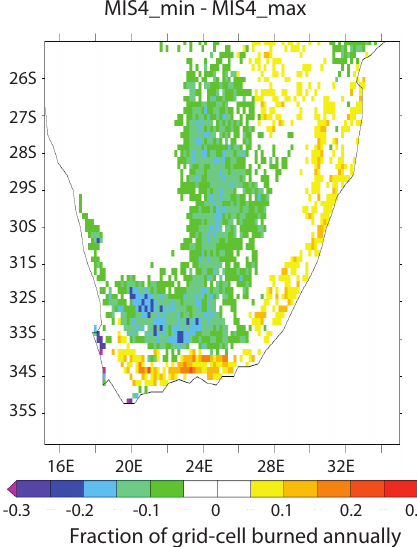
Figure 12. Difference (MIS4_min–MIS4_max) in the percentages of a grid cell burned during a year when precession